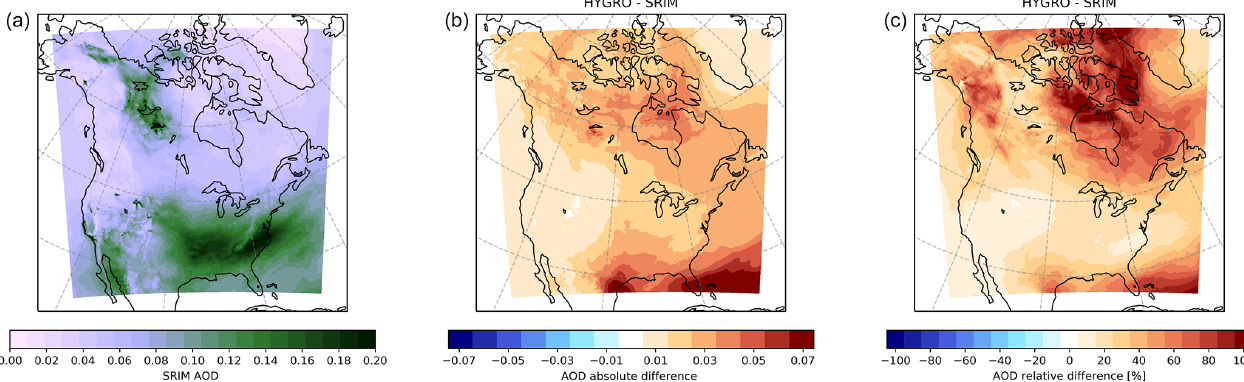
Figure 6. (a) Mean AOD from the SRIM simulation, (b) mean difference in AOD between the HYGRO and SRIM simulations, and (c) relative difference in mean AOD between the HYGRO and SRIM simulations. Only results from the hours of 13:00–21:00UTC are included as the AOD is only calculated during local daylight